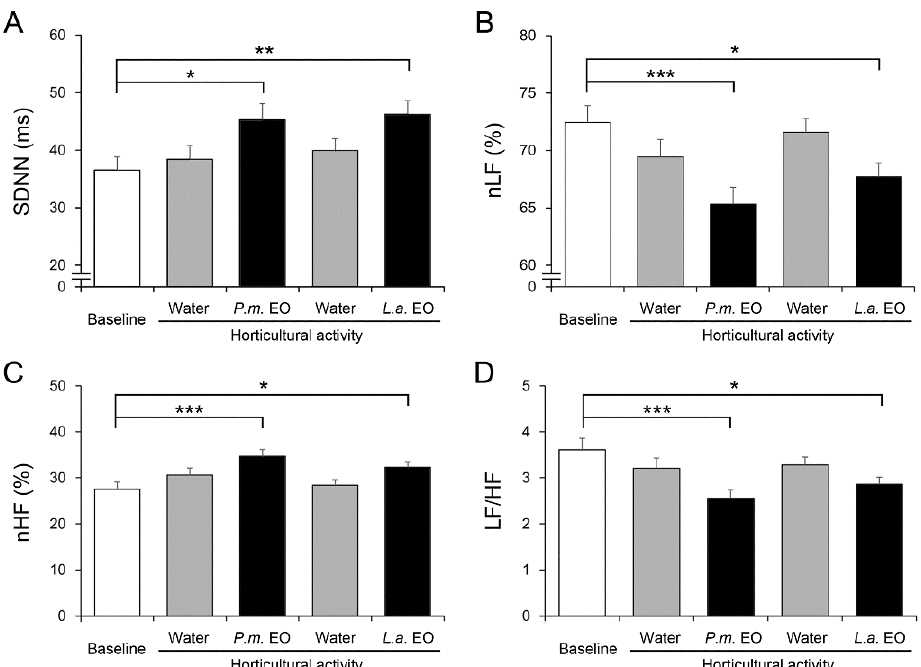
Figure 2. The heart rate variability (HRV)-related physiological parameters. Following the baseline period, an indoor horticultural activity, leaf printing, began. During the leaf printing procedure, water vapor (water), water vapor with Pseudotsuga menziesii essential oil ( P.m. EO), water vapor (water), and water vapor with Lavandula angustifolia essential oil ( L.a. EO) were given in an orderly manner. The values of SDNN (standard deviation of normal to normal intervals) increased during the exposures of both EOs ( A ). The percentages of nLF (normalized low frequency) reduced while the participants were breathing EOs ( B ). Correspondingly, the percentages of nHF (normalized high frequency) increased while breathing EOs ( C ). The LF/HF ratio decreased when both EOs were given ( D ). Data were collected from 92 participants and presented as mean ± SE. *, p < 0.05; **, p < 0.01. ***, p < 0.001, Wilcoxon signed-rank test.